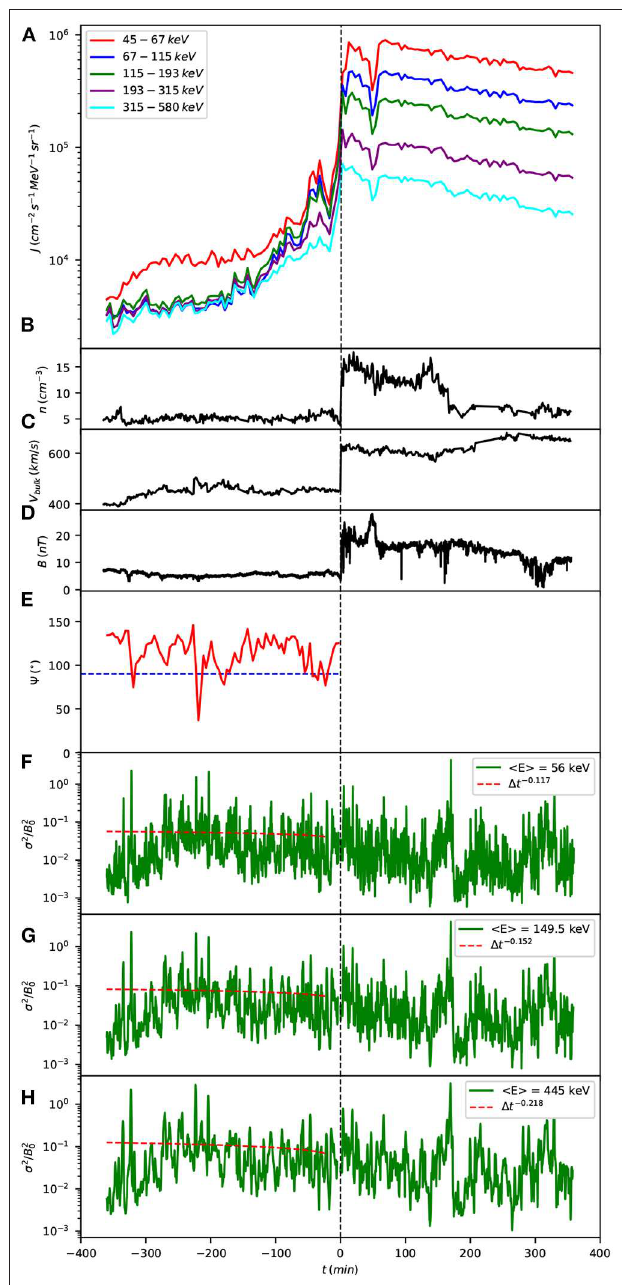
FIGURE 5 | Same as Figure 1 but for the ACE shock crossing of 26 August 1998. The shock normal angle was θ Bn = 98 ◦ .